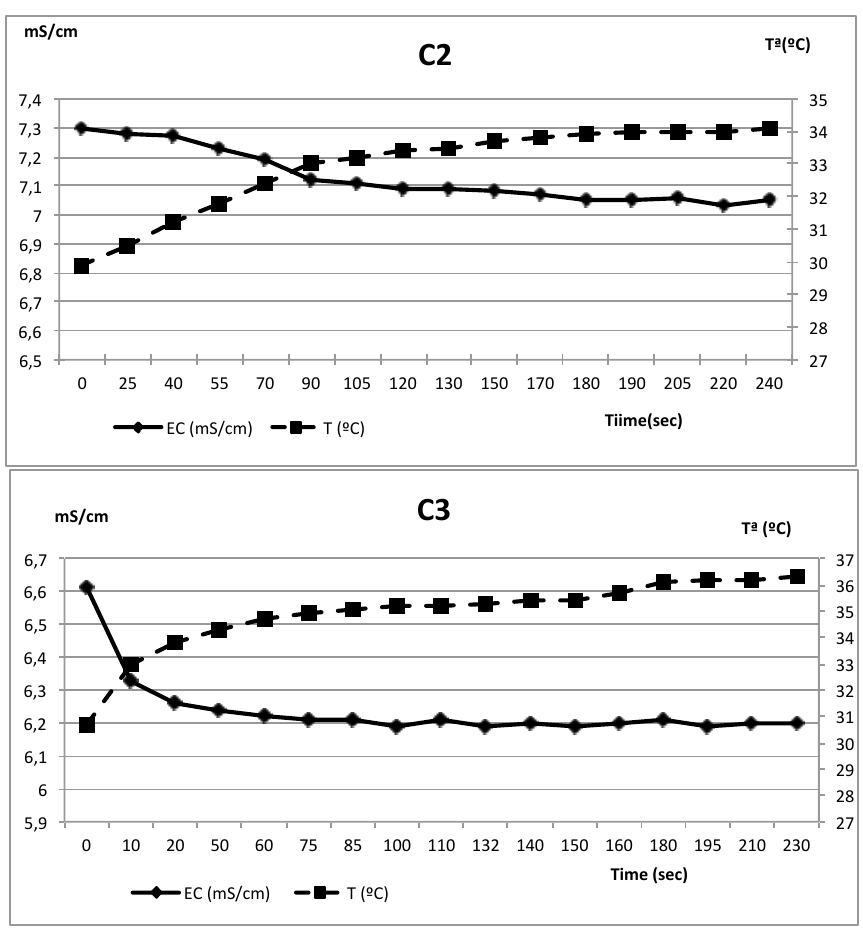
Figure 14. Evolution of lectures of temperature and EC in saline water solutions.